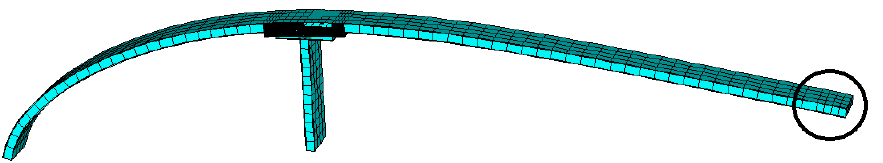
Figure 7. Suction side of the rotor blade to illustrate assumptions made at the trailing edge (black circle).